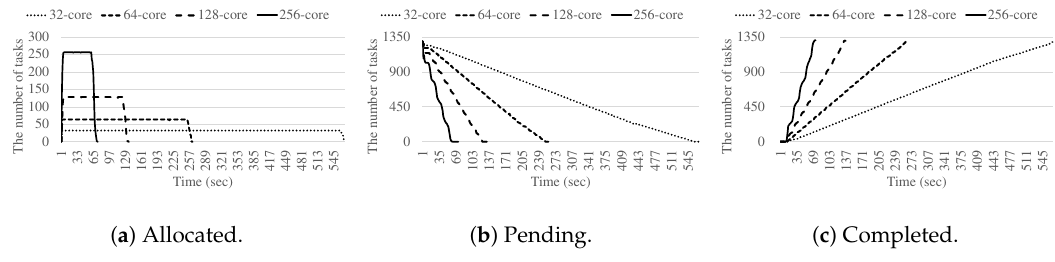
Figure 12. The number of allocated, pending, and completed tasks over time for the 401.bzip2